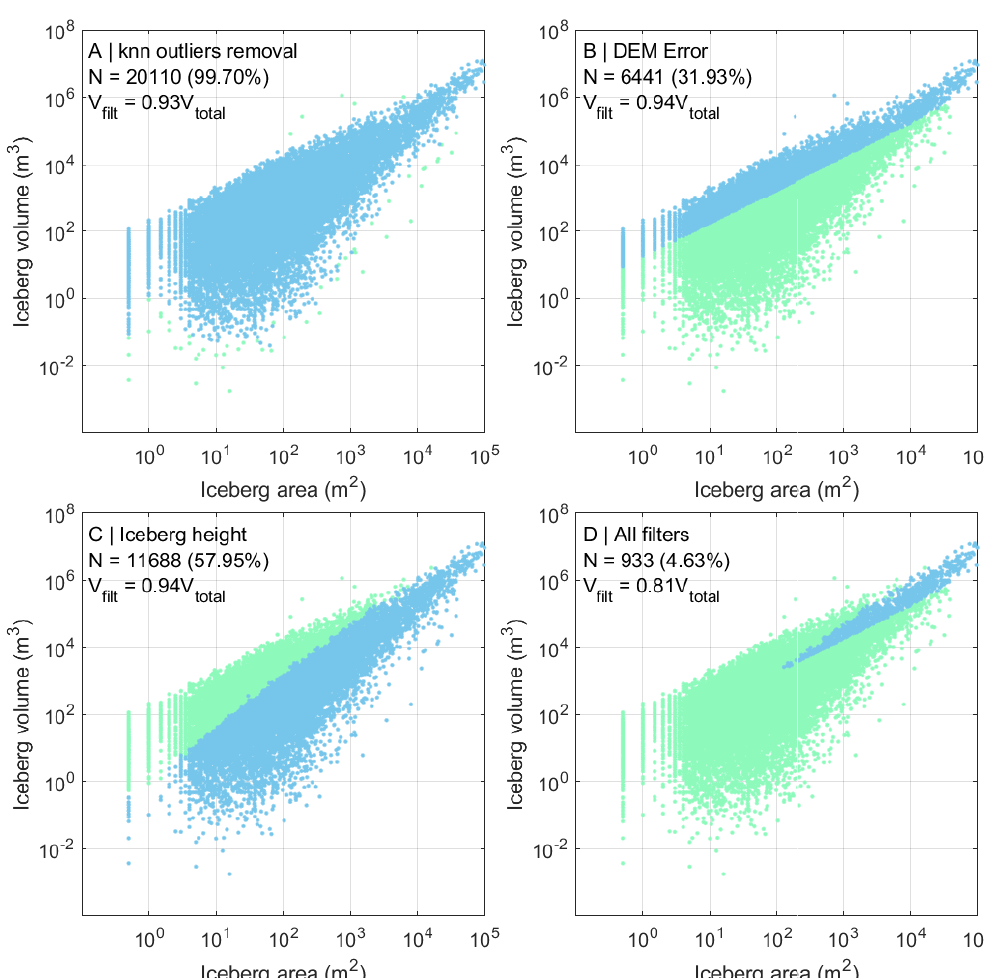
Figure 9. Subsets of the area–volume dataset produced by applying different filters. Discarded data points shown in green: ( A ) outliers removal with knn clustering ; ( B ) icebergs with µ Z rel < 1.7 m removed; ( C ) icebergs with width/height ratio below 0.73 removed; and ( D ) all filters applied together. Discarded points shown in green, and the accepted ones in